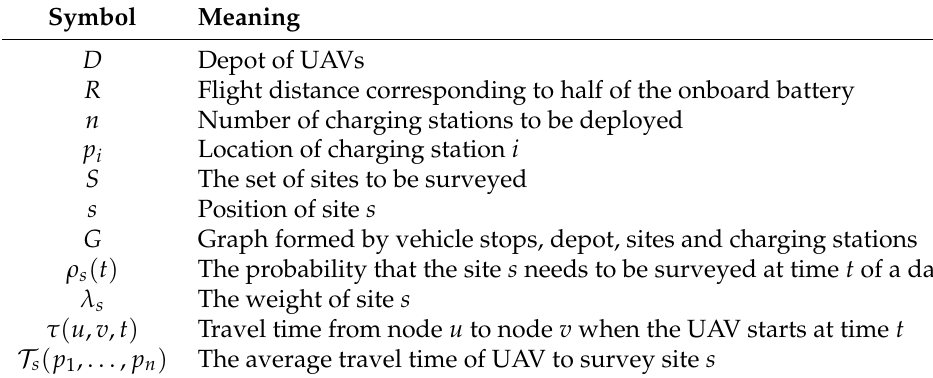
Table A1. Main symbols used in the